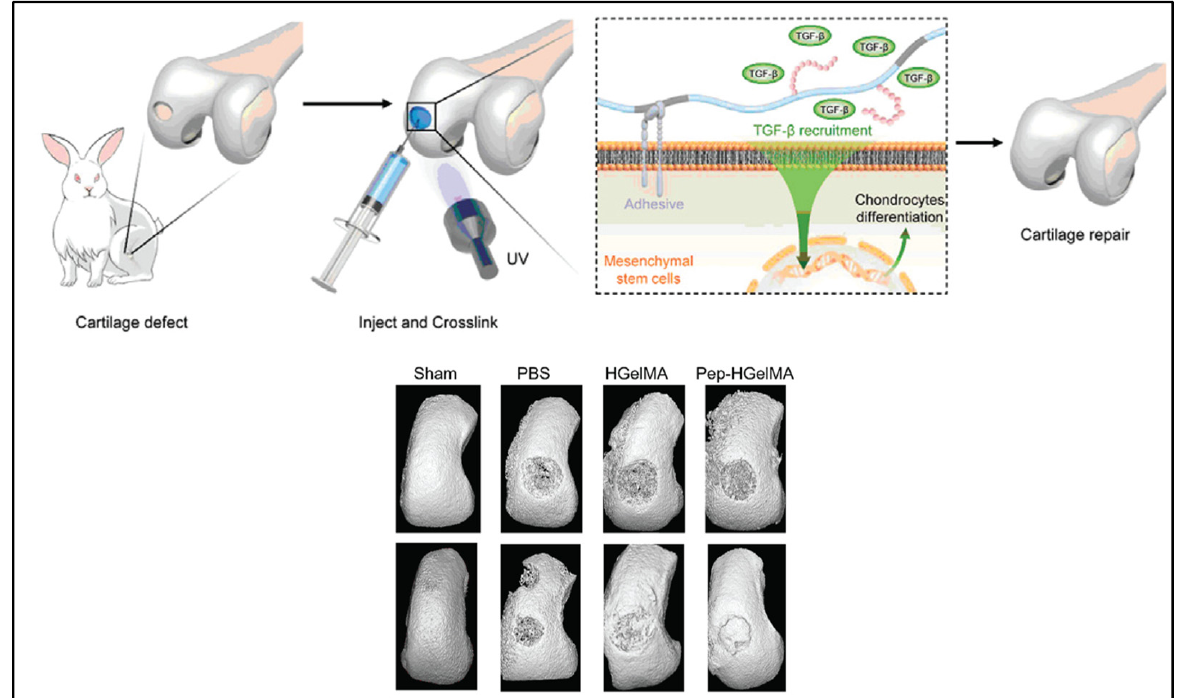
Figure 3. A schematic illustration of a novel photo-crosslinked GelMA hydrogel and HSNGLPL-MA recruits endogenous TGF- β 1 and enhances cartilage regeneration. A 3D reconstruction of micro-computed scans after cartilage repair with GelMA modified with TGF- β 1 affine peptides in rabbits. Reproduced (adapted) with permission from Ref. [30]. 2021 © Smart Materials in Medi- cine.